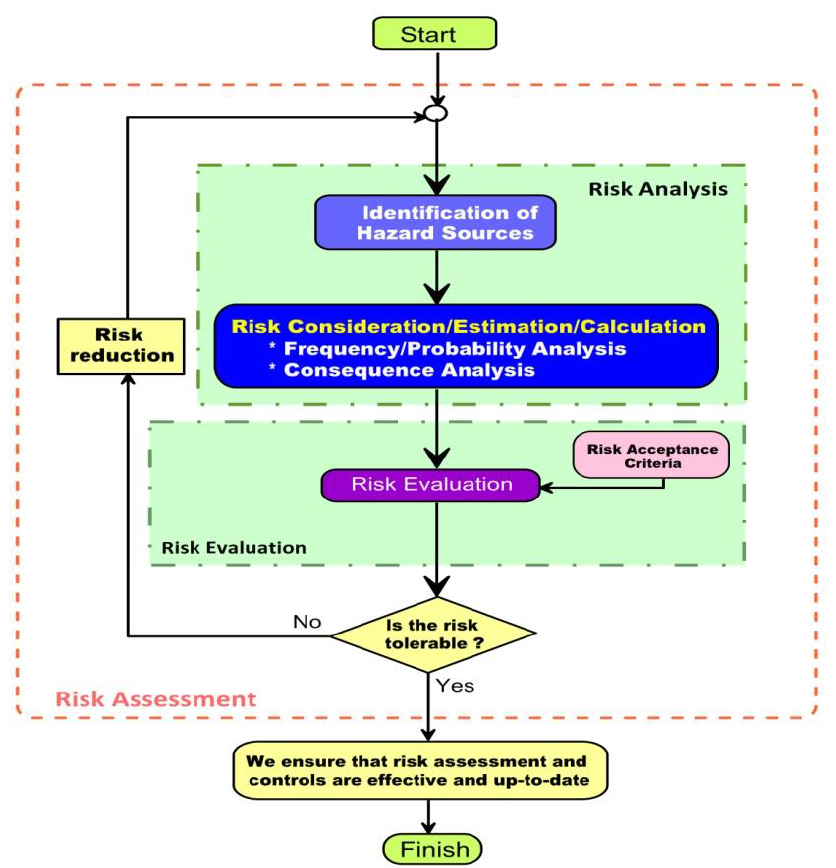
Figure 1. The process flow sheet of risk management (RM), taking into consideration OHS guidelines of ISO-IEC (1999, 2009) [4,5,14], including the treatment of the risk-acceptance criteria.